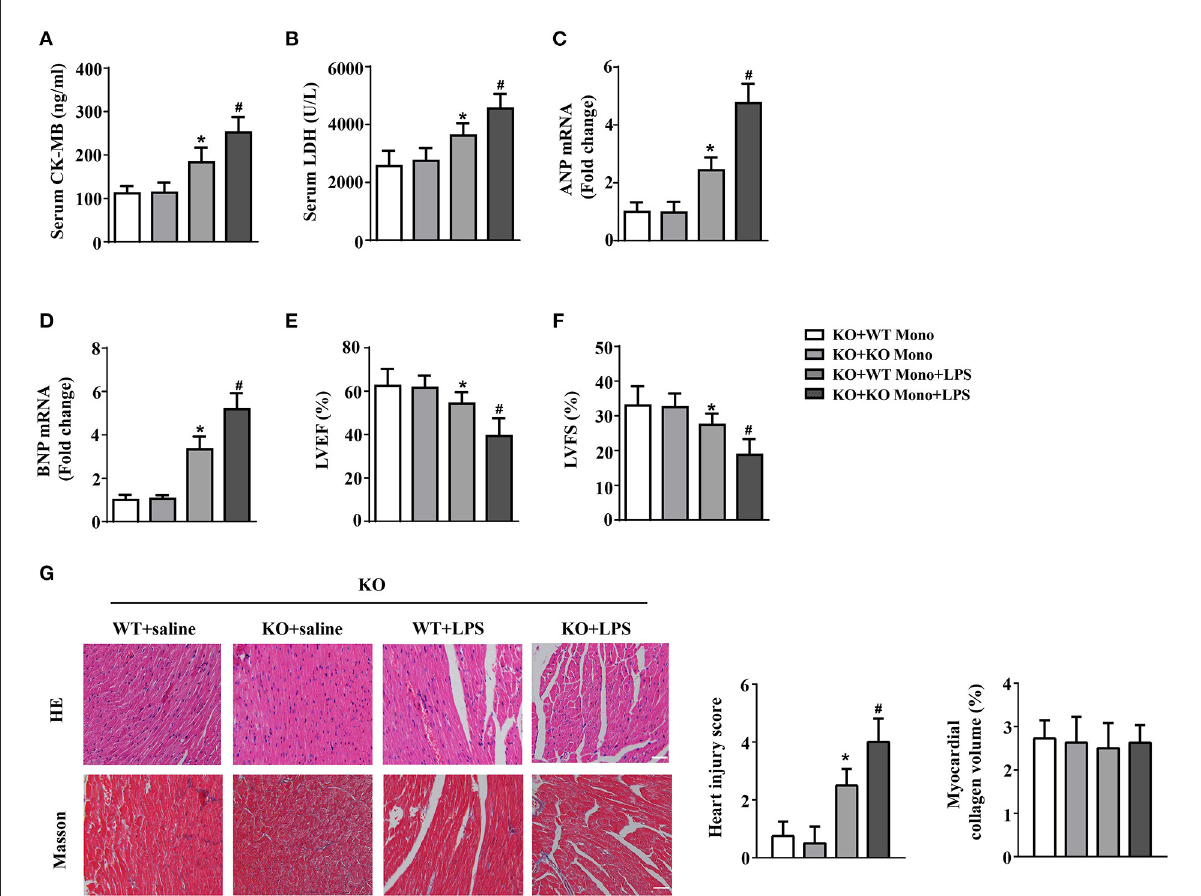
FIGURE6 WT monocyte adoptive transfer alleviates cardiac injury in LPS-treated IL-12p40 − / − mice. (A,B) The levels of LDH and CK-MB in serum of mice in each group ( n = 6). (C,D) qRT-PCR analysis of ANP and BNP mRNA expression levels in the hearts of mice in each group ( n = 6). (E,F) Echocardiography analysis of LVEF and LVFS of mice in each group ( n = 6). (G) HE and masson’s trichrome stainings and the quantitative results of heart tissues in each group ( n = 6; scale bar, 100 µ m). * P < 0.05 compared with the KO + WT Mono group. # P < 0.05 compared with the KO + WT Mono + LPS